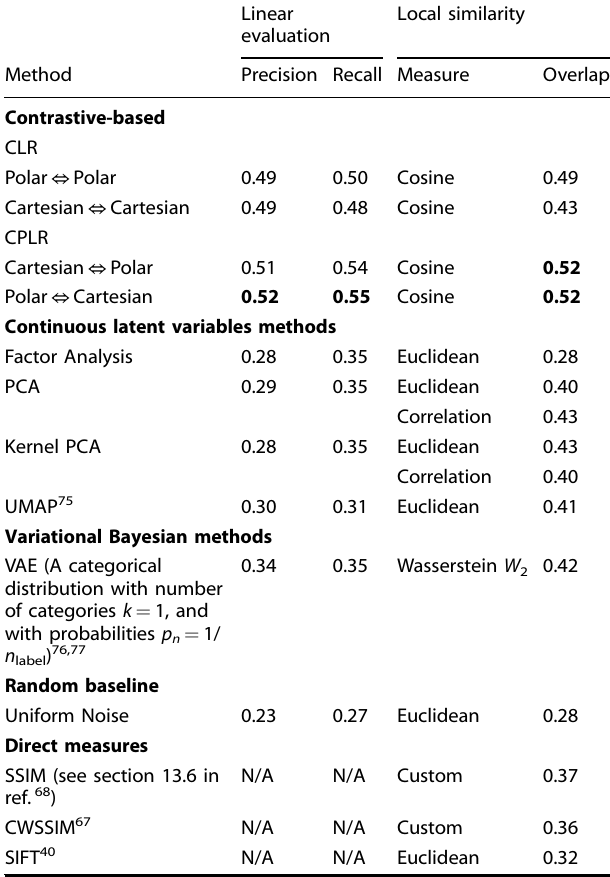
Table 1. Macroaverage (The macroaverage computes the average independently for each class and then takes the global average. Thereby, treating all classes equally. A microaverage aggregates each contribution of all classes fi rst and averages that. For a discussion on macro- and microaveraging see section 13.6 in ref. 68 .) results on the helium nanodroplets